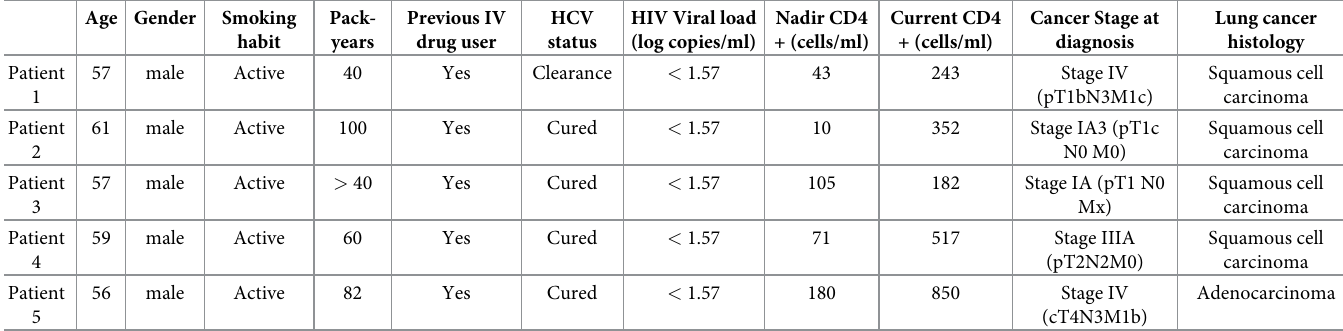
Table 2. General characteristics of patients with lung